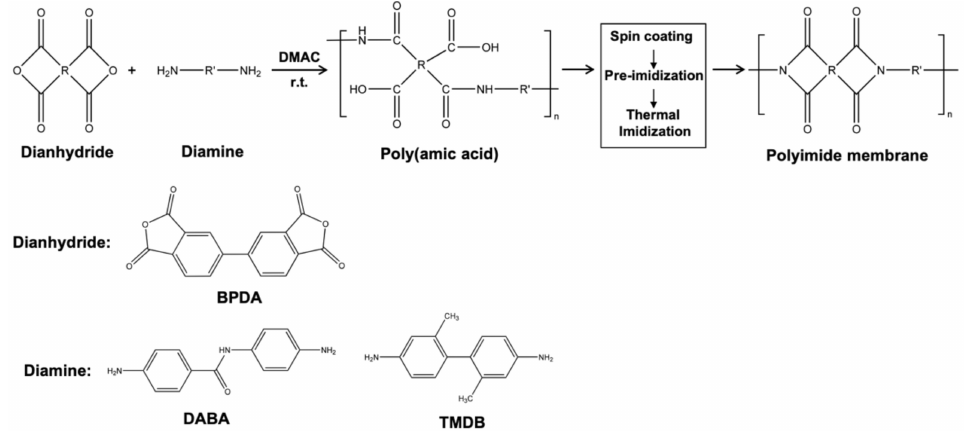
Figure 1. The synthesis of Poly(amic acid) and preparation process of PI membrane.